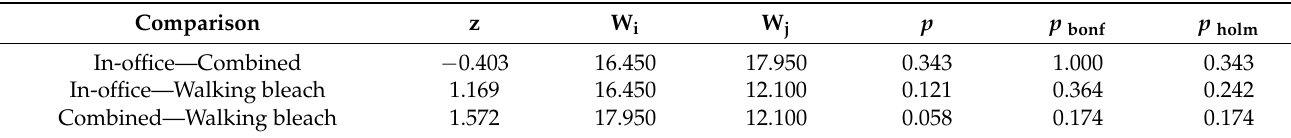
Table 4. Comparison of pair of bleaching techniques.